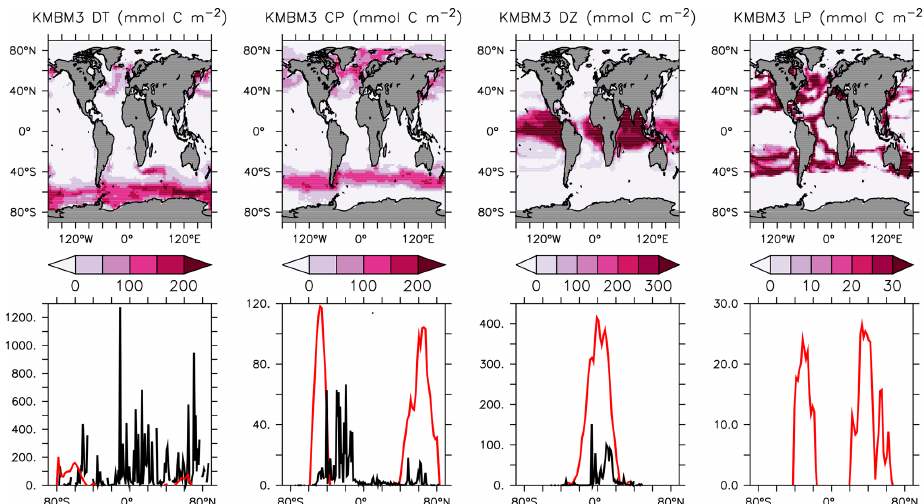
Figure 5. Annually averaged and depth-integrated model biomass at the year 2014 (top row). Zonally averaged and depth-integrated model biomass plotted with the equivalent MAREDAT compilations (bottom row; Leblanc et al., 2012; O’Brien, 2012; Luo et al., 2012; no data compilation of “mixed” phytoplankton, a model-specific category). All units are mmolCm − 2 . Black lines represent MAREDAT; red lines are the model